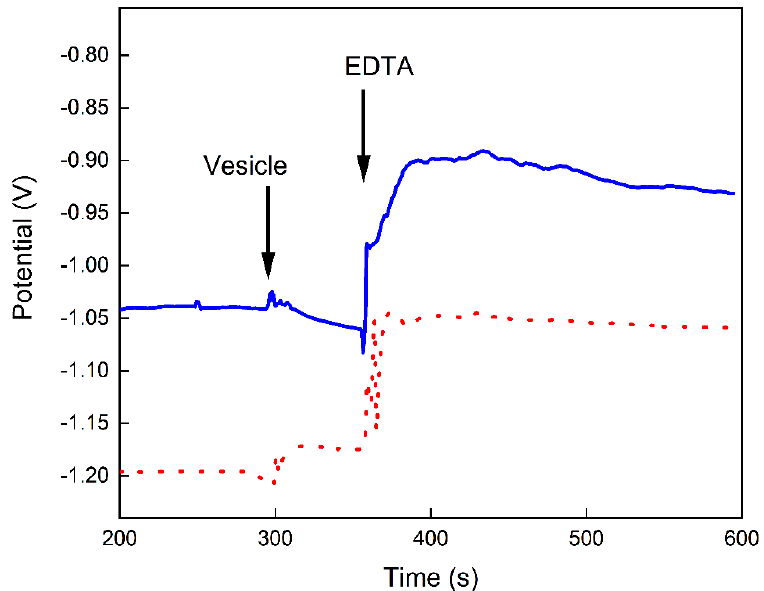
Figure 6. Potential (V) versus time (s) curve recorded using the BNCD microelectrode in media containing 1 mM of Ca 2+ ions in Tris 16 mM, pH 7.5. After equilibration, at 300 s, 10 μ L of liposomes (0.6 mg/mL of total lipid) (dotted line) and proteoliposomes (0.6 mg/mL of total lipid containing 14 μ g/mL of AnxA5) (continuous line) were added, followed by the addition of 4 μ L of 2.5 mM EDTA at 360 s. A potential drop of ~30 mV is clearly visible from 300 to 360 s in the recording with proteoliposomes. Table 1. Summary of all measurement variations and the respective results. Recordings 1 to 4 and 17 are negative controls, i.e., without liposomes/proteoliposomes. All measurements with Tris-buffer in the initial solution present smaller potential variations due to the buffering